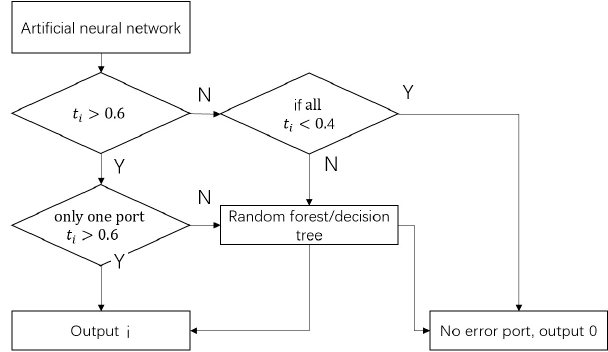
Figure 11. The flowchart of the diagnosis procedures.